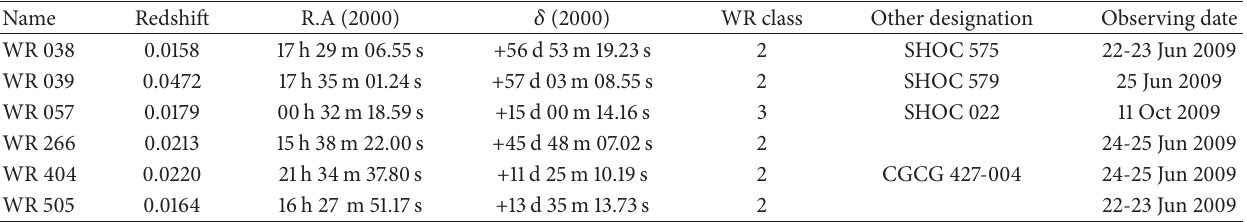
Table 1: The sample of observed Wolf-Rayet galaxies with different properties, including names, redshifts, positions, WR index, and date of observations with